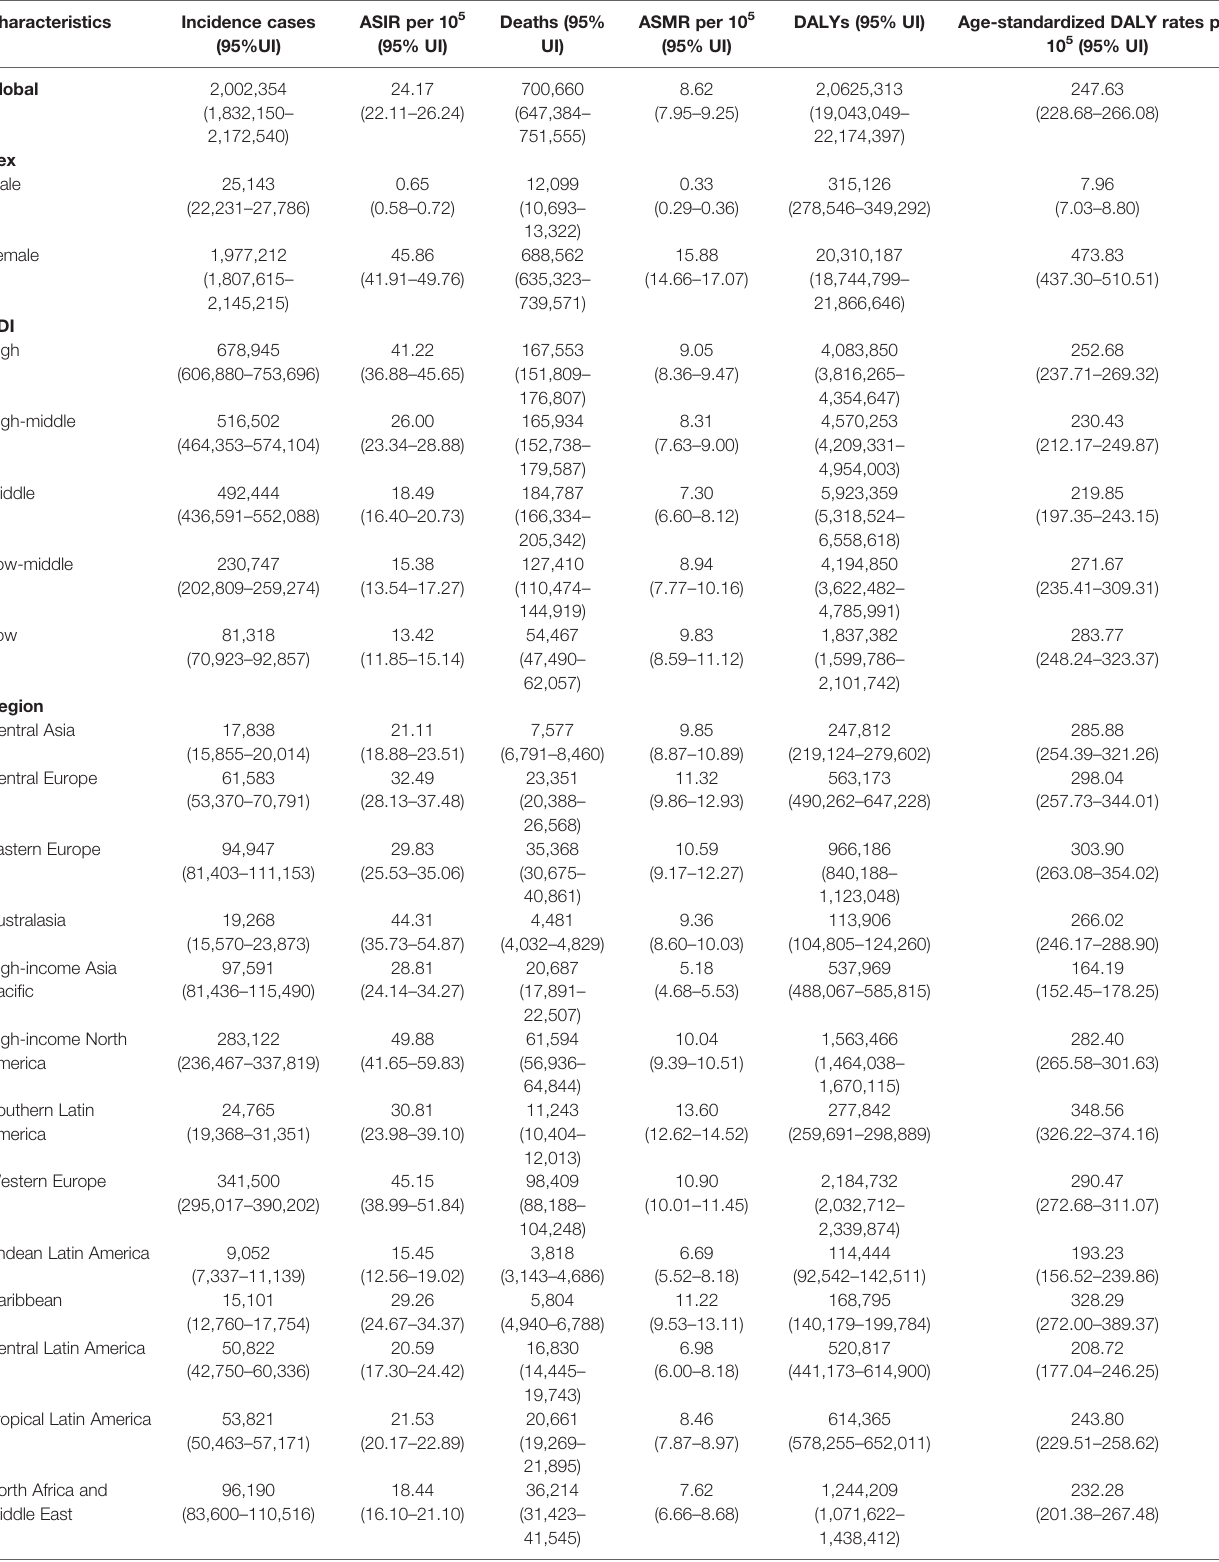
TABLE 1 | Breast cancer incidence cases, age-standardized incidence rate, deaths, age-standardized mortality rate, DALYs, and age-standardized DALY rates in 2019.